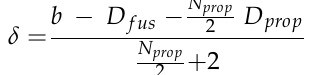
Figure 9. Visualization of the clearance between the propellers. Table 9. Main constraints for the box-wing tilt-wing conceptual design. MTOW <3175 kg, according to [32] Wingspan <13 m, according to [38] Clearance between propellers >0.1 m The clearance between propellers has been evaluated according to Equation